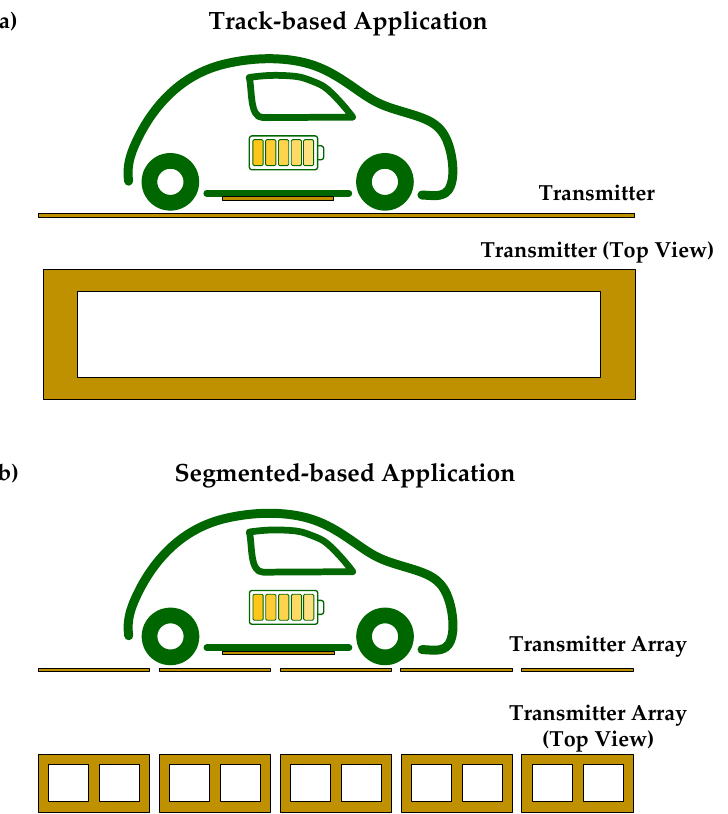
Figure 7. Transmitter coil configuration: ( a ) track-based; ( b ) segmented-based.